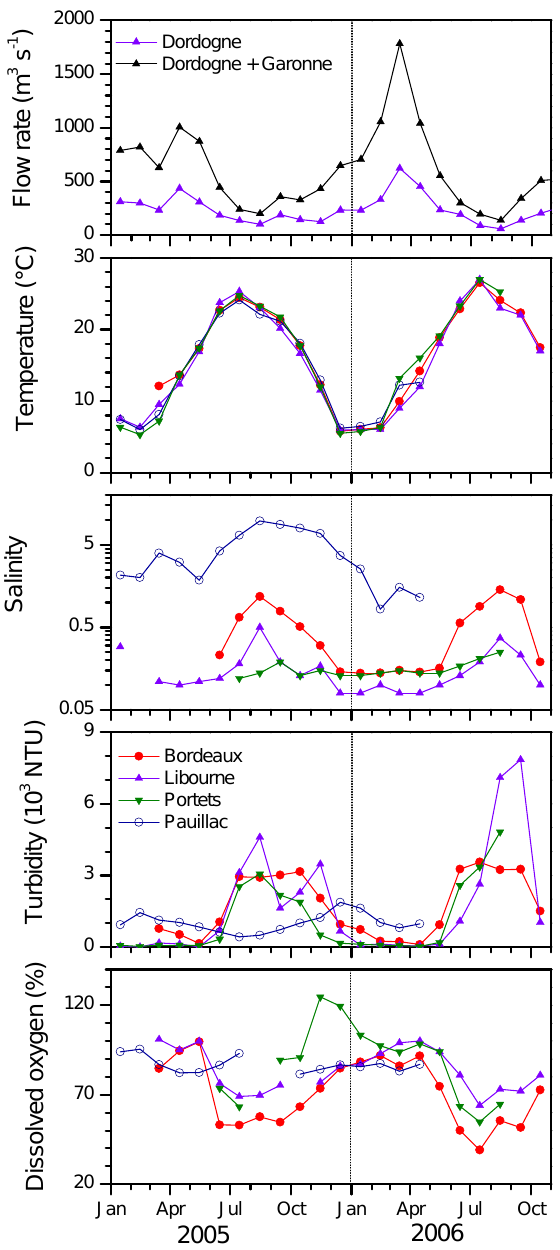
Fig. 4. Comparison of monthly changes in flow rate (m 3 s − 1 ) , tem- perature ( ◦ C), salinity, turbidity (10 3 NTU) and dissolved oxygen (% of saturation), from January 2005, to October 2006, among the stations Bordeaux (circles), Libourne (up-triangles), Portets (down- triangles) and Pauillac (circles) of the MAGEST